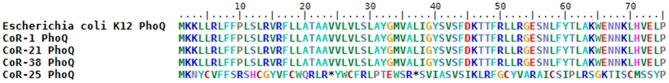
Partial sequence alignment of the PhoQ protein in CoR-25 and the control strains. The controls share the same amino acid sequence; CoR-25 PhoQ harbors a K to N substitution at position 3, which results in a premature stop codon at codon 24 and truncation of the PhoQ protein.